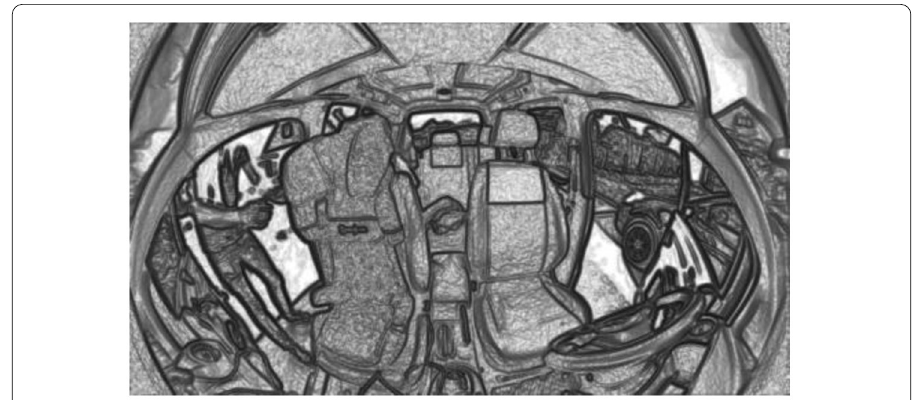
Figure 12 A gray scale real-world image after the application of the pre-processing P MGAC